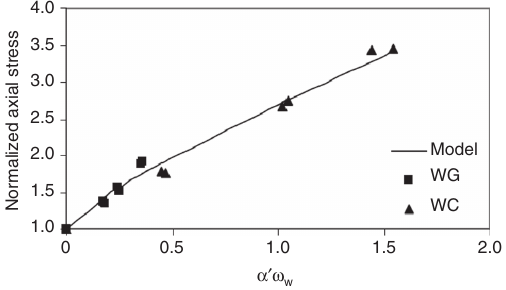
Figure 10 WG4 specimens: (A) normalized axial stress versus volu- metric strain, (B) normalized strain versus volumetric strain.